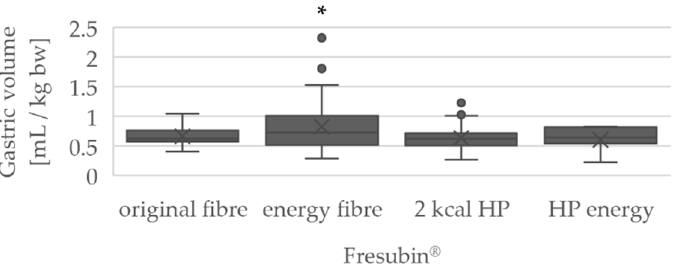
Figure 4. Boxplots of the GRV in mL/kg bw according to nutritional product used, * p < 0.05 (Fresubin ® energy fiber versus original fiber). For the quantity of uses of the products, see Table A1. If the patient was fed with the standard product Fresubin ® original fiber, the average GRV was 0.66 ± 0.15 mL/kg bw. With the second standard product Fresubin ® energy fiber,